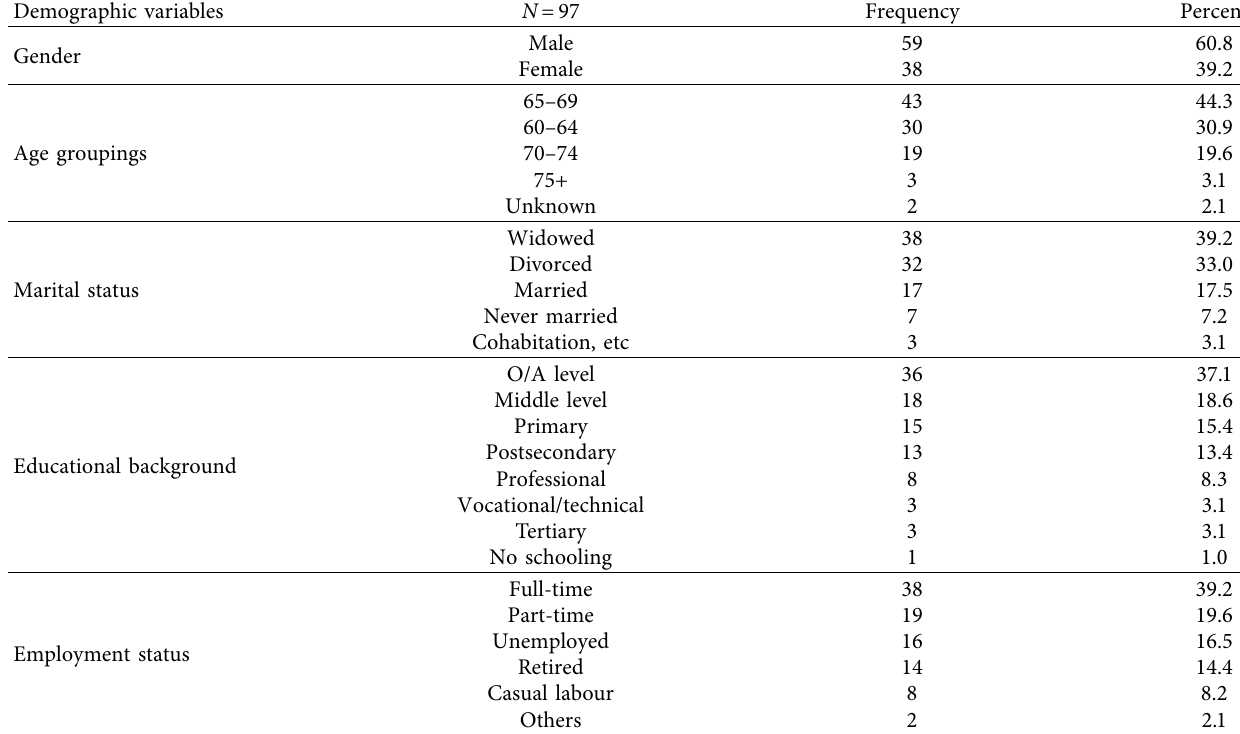
Table 1: Sociodemographic characteristics of study participants.